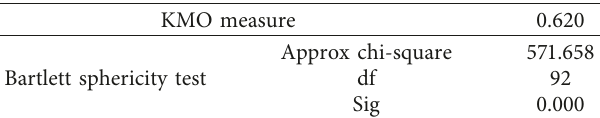
Table 2: KMO and Bartlett test.